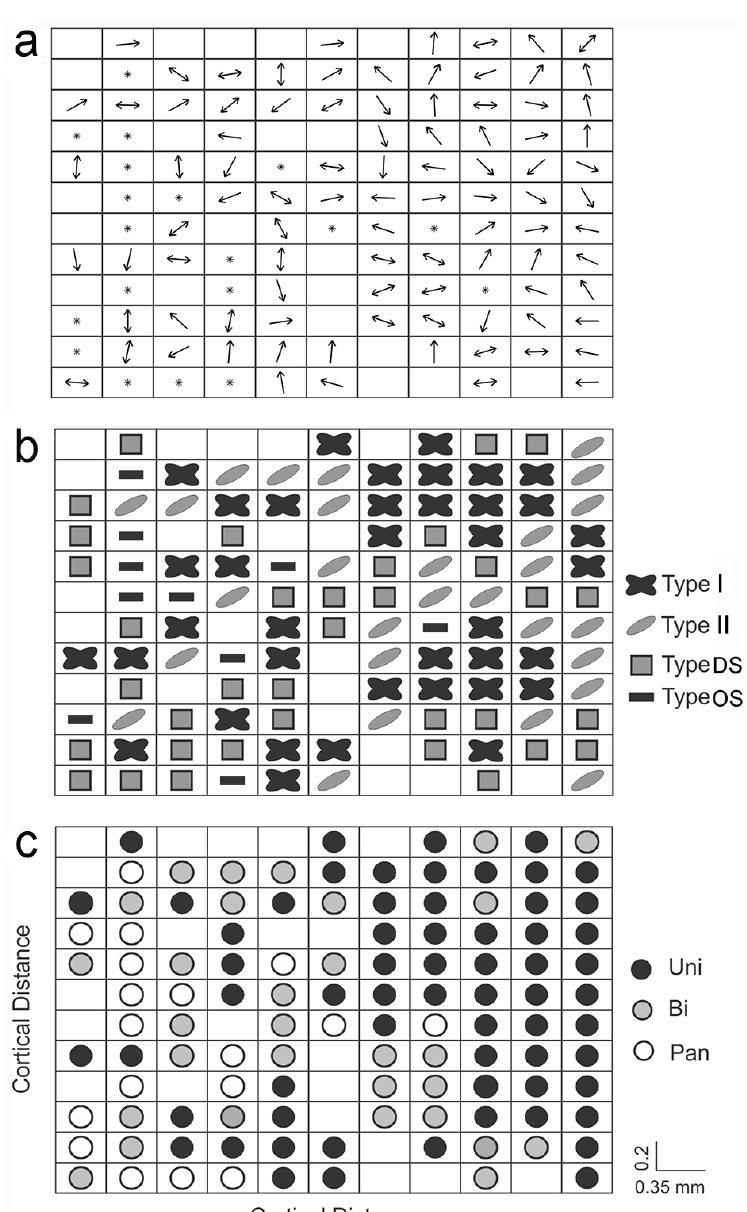
Figure 4. Two-dimensional surface maps of area MT. (a) Selectivity profile for the tangential plane in which we obtained the largest number of responsive sites. (b) Two-dimensional surface map for cell type. (b) Two- dimensional surface map for directions